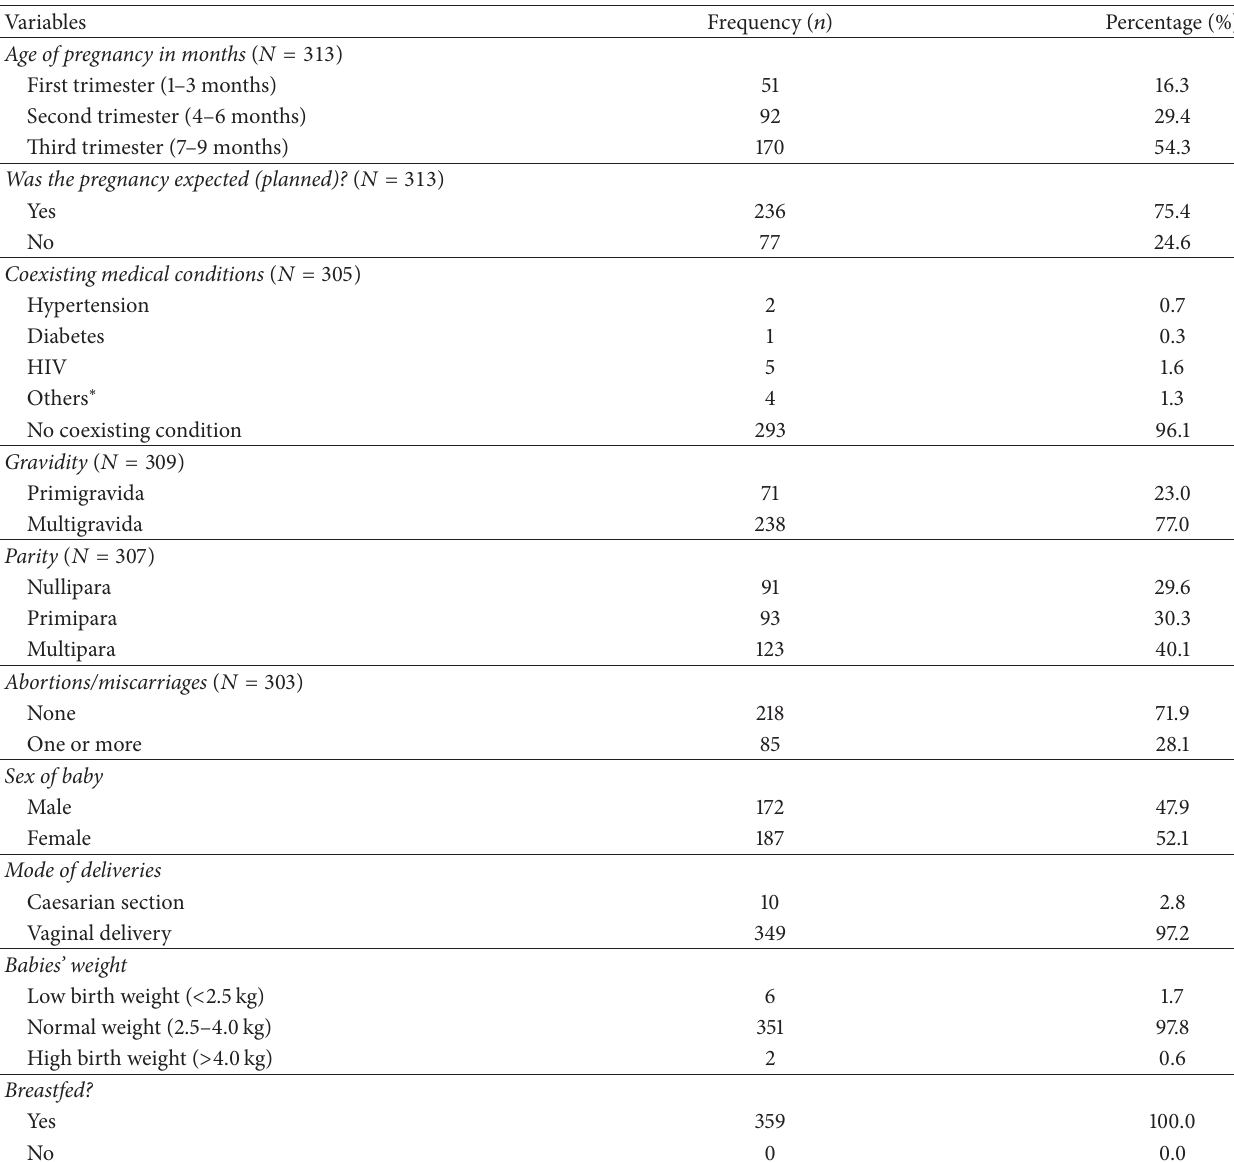
Table 2: Frequency distribution of respondents by history of index pregnancy and past gynaecological/obstetric history among respondents.